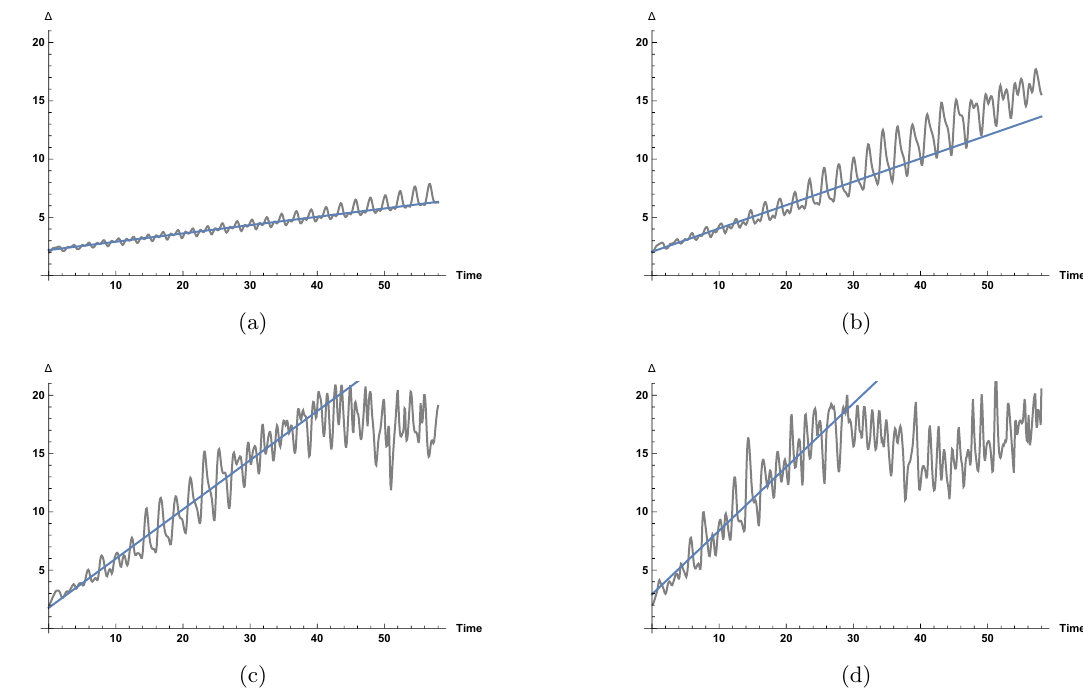
Figure 8 . The range of the bi-local (cid:12)eld de(cid:12)ned in eq. (3.12) plotted as a function of time for (a) (cid:15) = 0 : 08, (b) (cid:15) = 0 : 12, (c) (cid:15) = 0 : 16, (d) (cid:15) = 0 : 2 with R = U = (cid:21) = 1 and L = 40. The straight lines represent the best linear (cid:12)ts of (cid:1)( t ) in 0 < t < 30.